Question: Provide a publication-style caption for this figure.
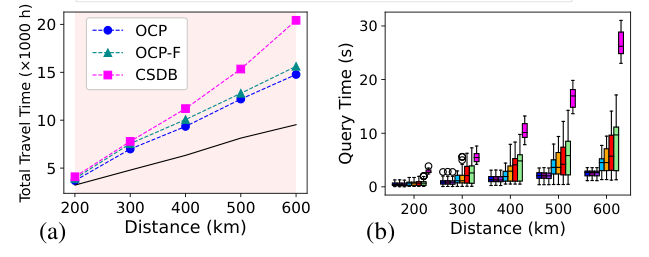
Answer: Performance for varying the travel distance in SDS when the number of EVs is 1000: a) Total travel time in SDS b) Mean query time in SDS.